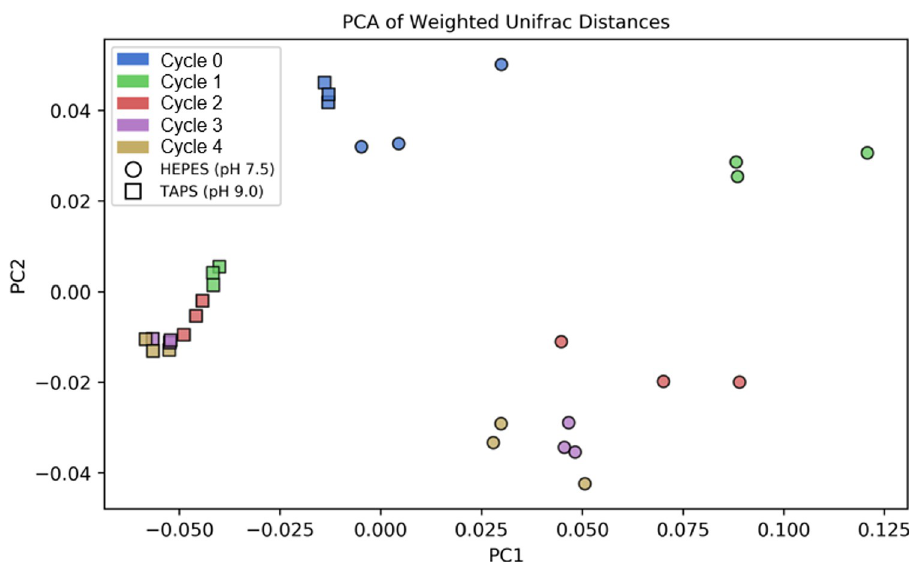
Fig 6. Principal component analyses of microbial community data. Weighted Unifrac Distances for 18s rRNA gene amplicon sequencing data showing the pH 9 reactors (squares) and pH 7.5 reactors (circles). Cycle number is indicated by color.